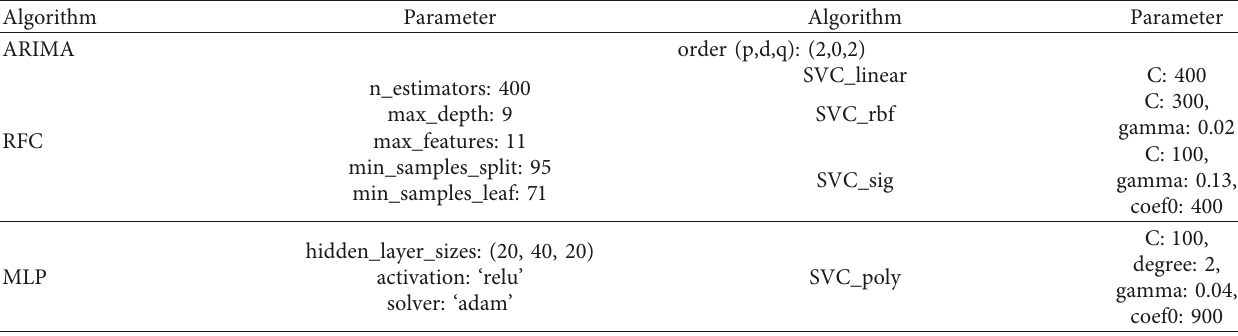
Table 6: The optimal parameter settings of the algorithms. Algorithm Parameter Algorithm Parameter